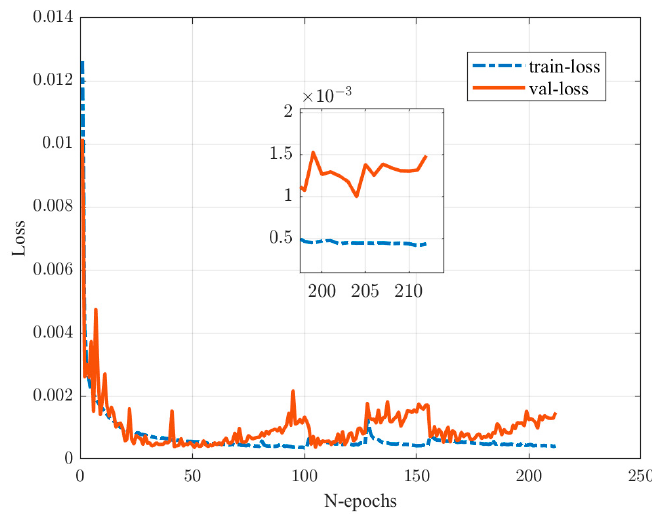
Figure 7. The loss curve during the training process.